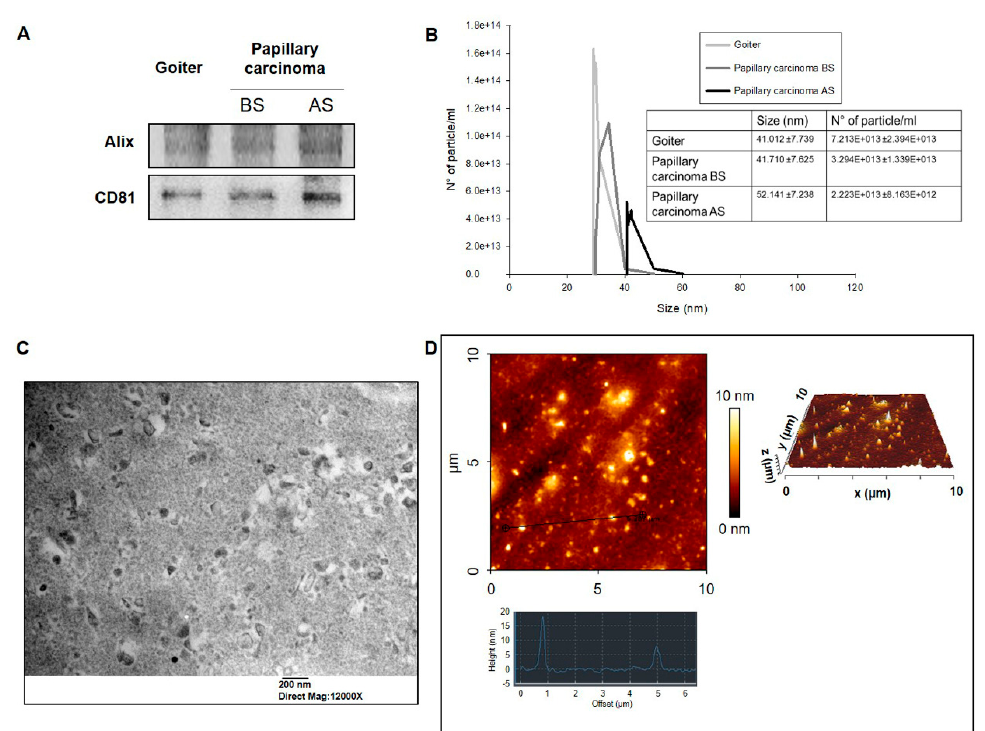
Figure 3. Exosome characterization. ( A ) Quantification and characterization by Western blotting (WB) of markers of exosomes from patients with goiter and papillary carcinoma before surgery (BS) and after surgery (AS). ( B ) Dynamic light scattering (DLS) characterization of exosomes showing their concentrations and their diameters. Mean ± SE of three different experiments are shown. ( C ) Transmission electron microscopy (TEM) (bar 200 nm) and ( D ) atomic force microscopy (AFM) images showing the typical characteristics of exosomes. Hsp27, Hsp60, and Hsp90 were present in the exosomes, but at different levels in BG and PC, being significantly higher in PC. Moreover, in PC the levels of the three chaperones were higher before surgery than after it (Figure 4A–D).